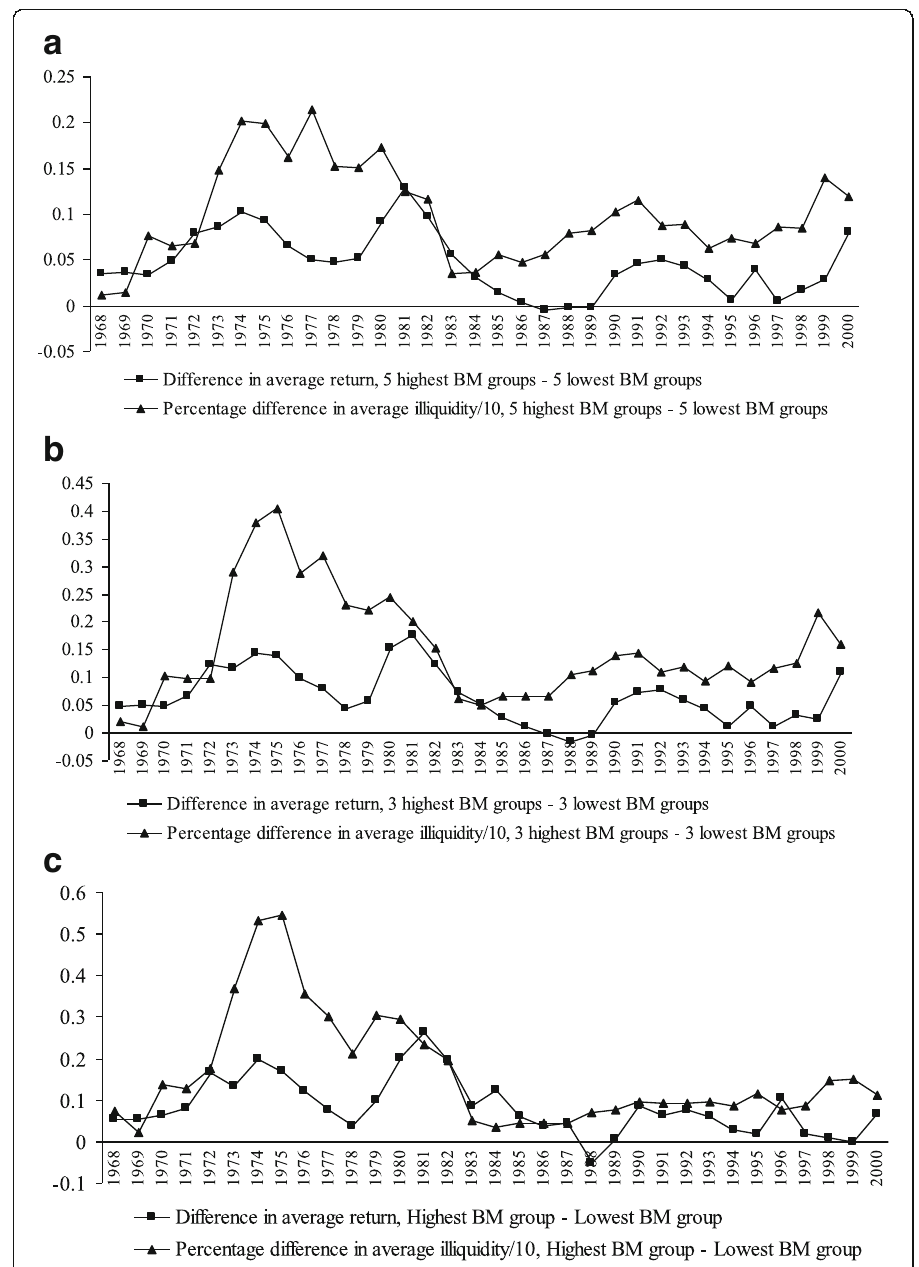
Fig. 2 Plot of annual differences in average return and annual percentage differences in illiquidity. Plot 2. A: Differences between the five highest and lowest BM groups. Plot 2. B: Differences between the three highest and lowest BM groups. Plot 2. C: Differences between the highest and lowest BM